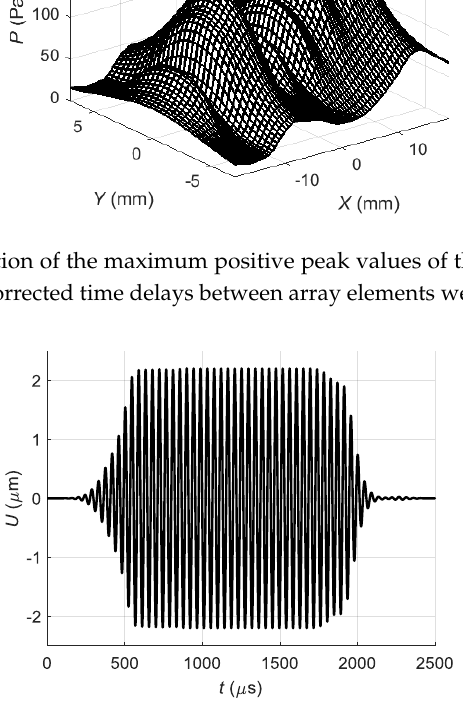
Figure 22. Impulse of normal displacement of the PVC film at the point P ND (Figure 8) when the corrected time delays between array elements are used.